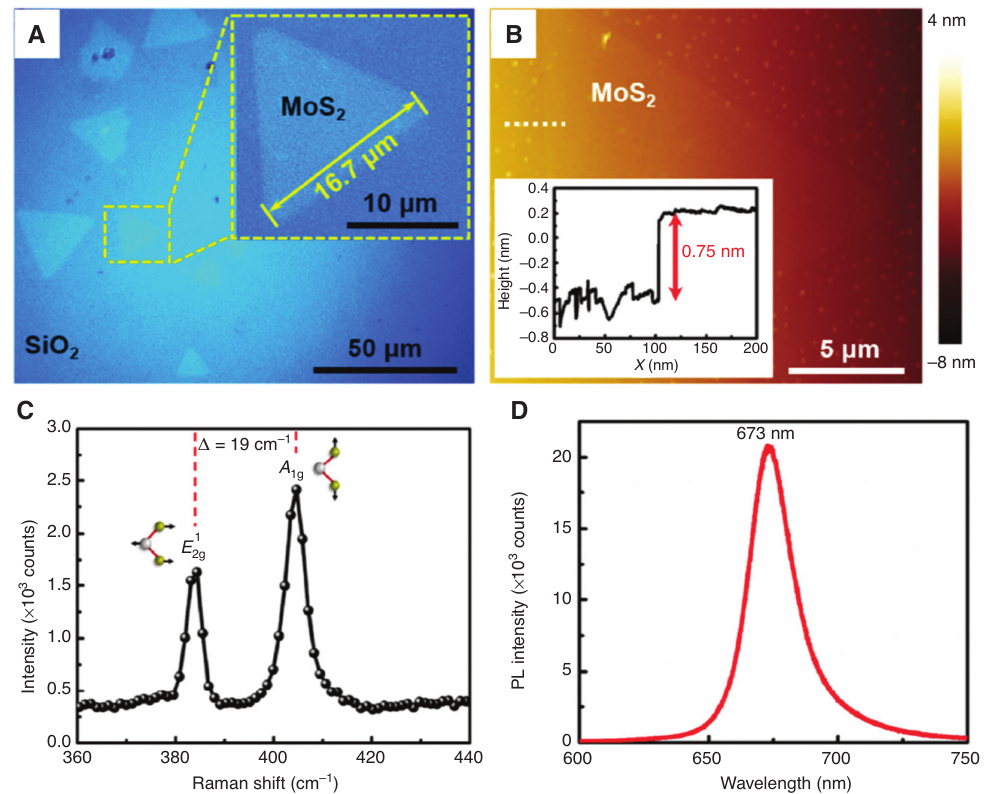
. 2 with a 16.7- μ m-long side. 2 . 2 with peak wavelength of 673 nm. Reprinted with 2